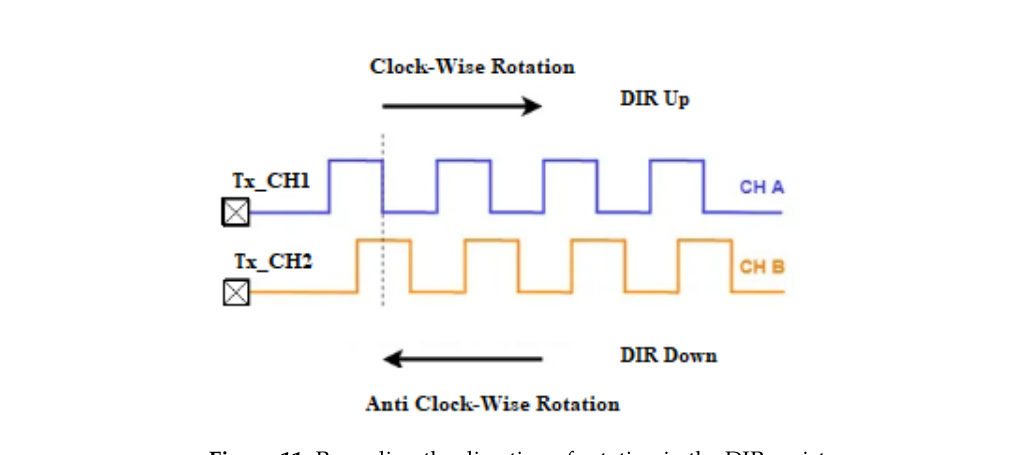
Figure 11. Recording the direction of rotation in the DIR register.